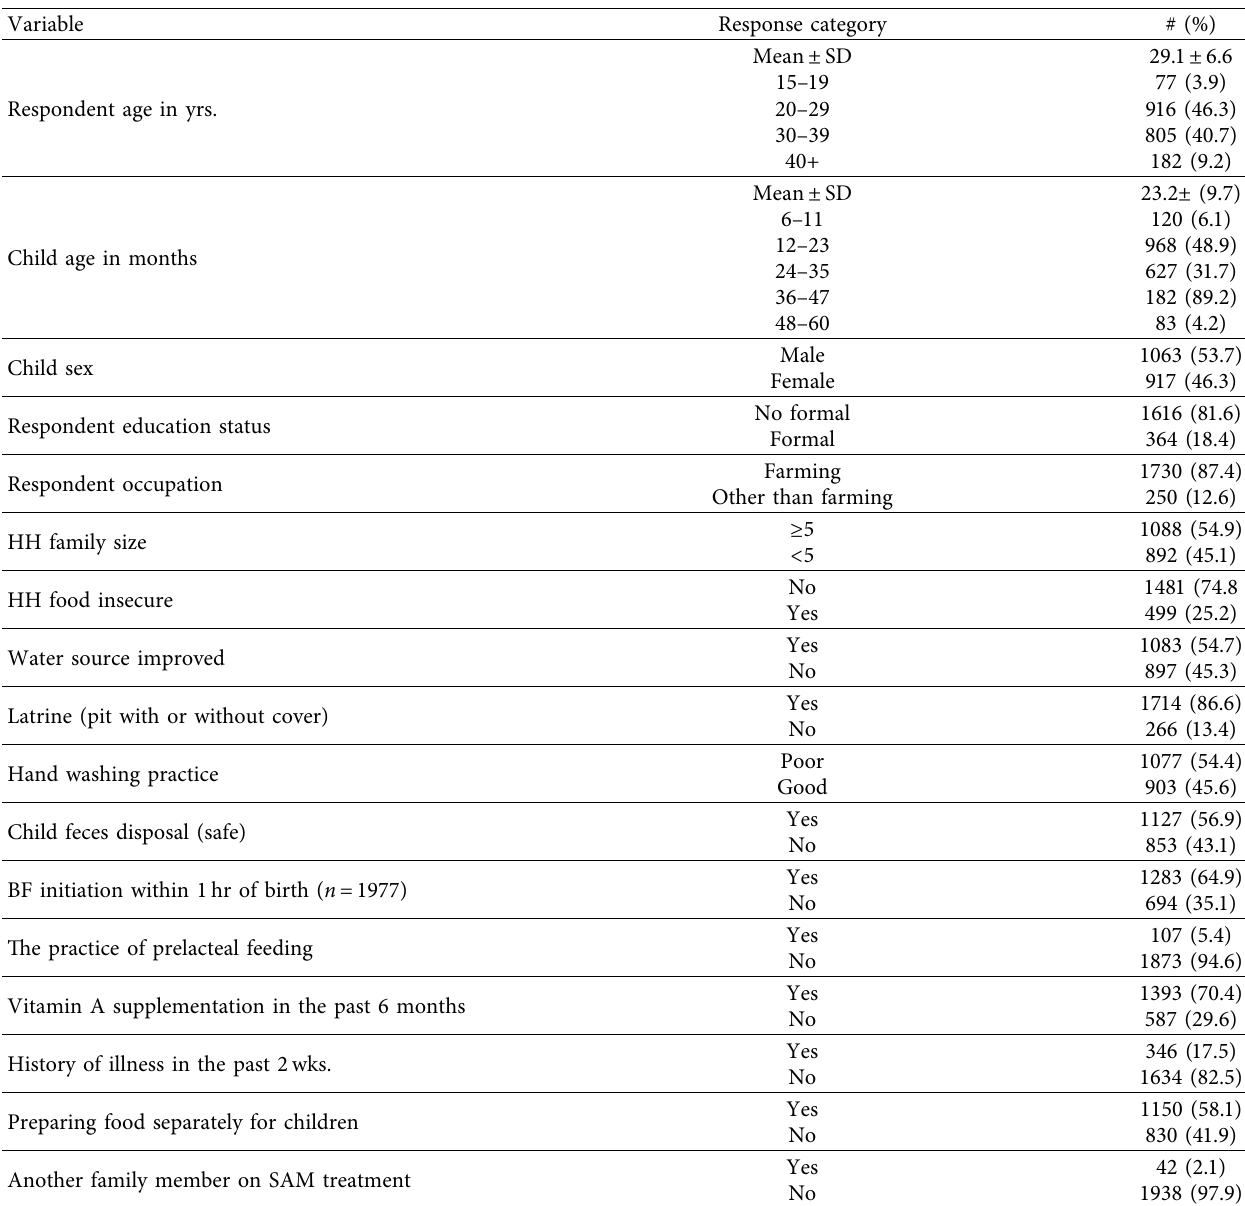
Table 1: Background characteristics of respondents and children aged 6–59 months, South Gondar Zone, Amhara Region, Ethiopia, 2017/ 18 ( n � 1980).